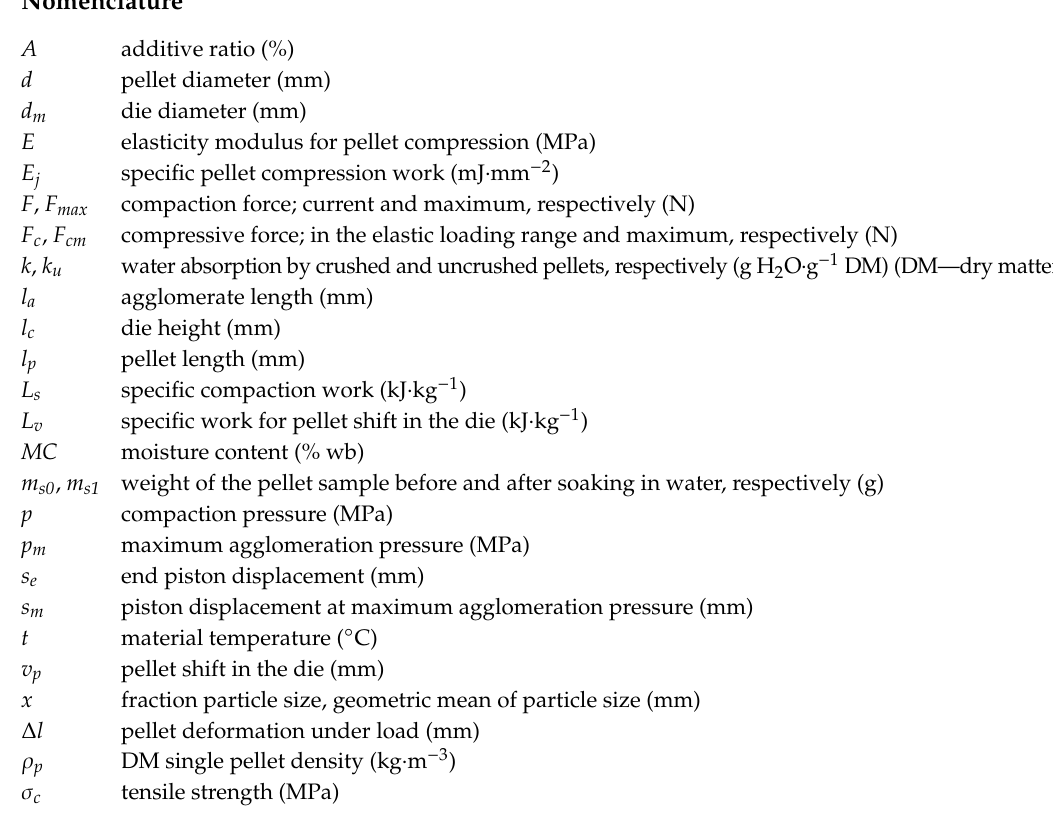
Figure S1: Pellet shift in die v p vs. piston displacement s m and the specific work of the pellet shift in the die L v , Figure S2: Pellet shift in die v p vs. piston displacement s m and the specific work of the pellet shift in the die L v , Table S1: Descriptive parameters of process pelletising and pellets properties, Table S2: Correlation matrix for type of additive, fraction particle size x , pellet dimeter d , DM single pellet density ρ p , elasticity modulus for pellet compression E , specific pellet compression work E j , tensile strength σ c , piston displacement at maximum agglomeration pressure s m , pellet shift in the die v p , specific compaction work L s , specific work for pellet shift in the die L v , water absorption by crushed pellets k , and water absorption by uncrushed pellets k u